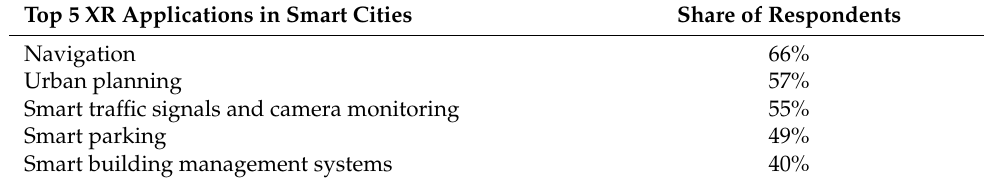
Table 6. Top 5 XR Applications in Smart Cities, source: